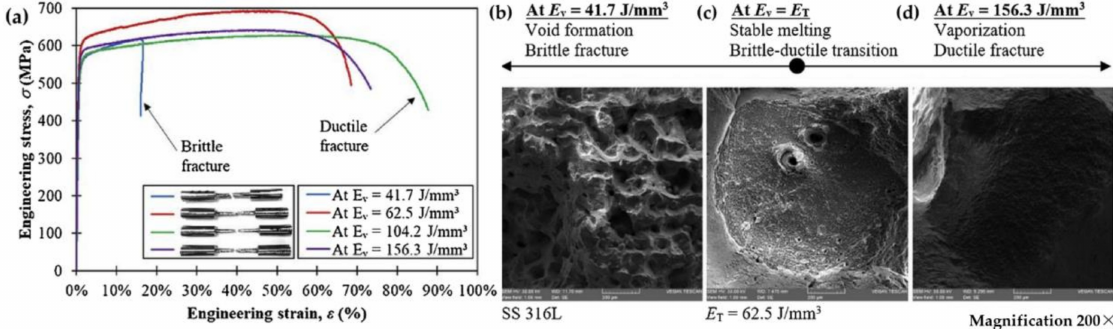
Figure 6. The ( a ) stress-strain curves and fractography of SLM 316L SS at the LED of ( b ) 41.7 J/mm 3 , ( c ) 62.5 J/mm 3 , and, ( d ) 156.3 J/mm 3 [92] Copyright 2022 Elsevier.